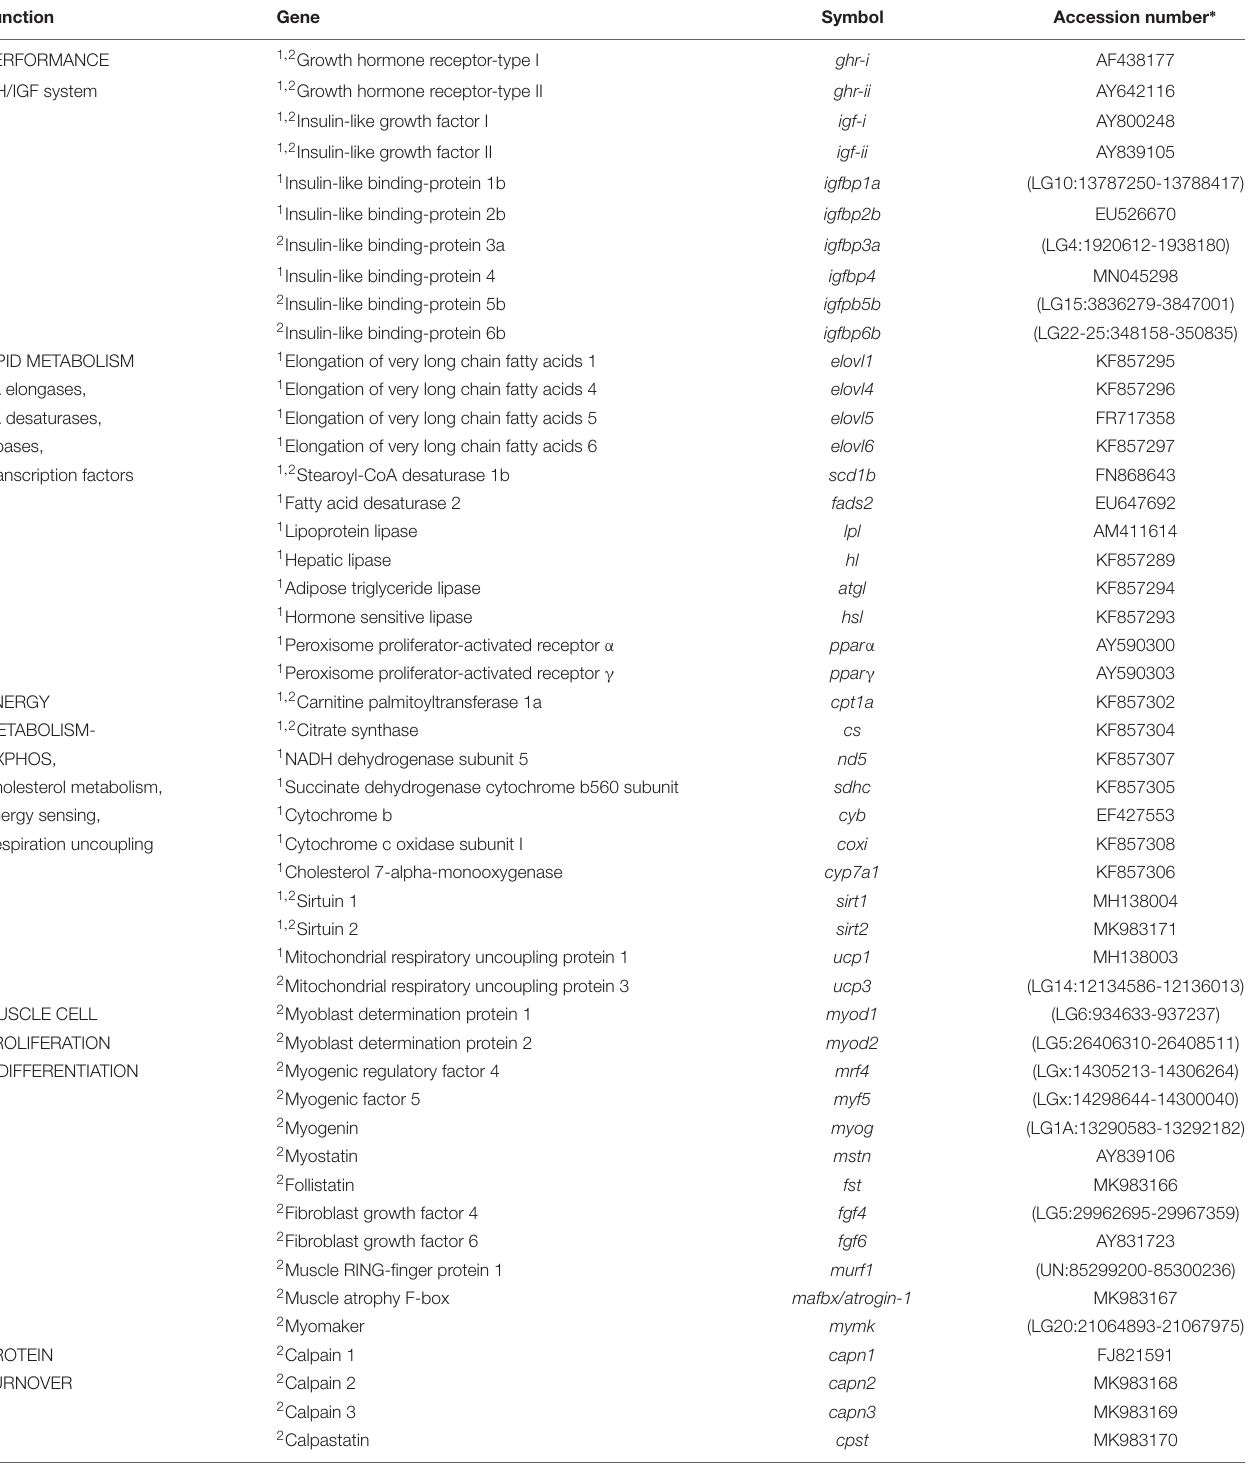
TABLE 3 | PCR-array layout for hepatic and white skeletal muscle gene expression profiling. Function Gene